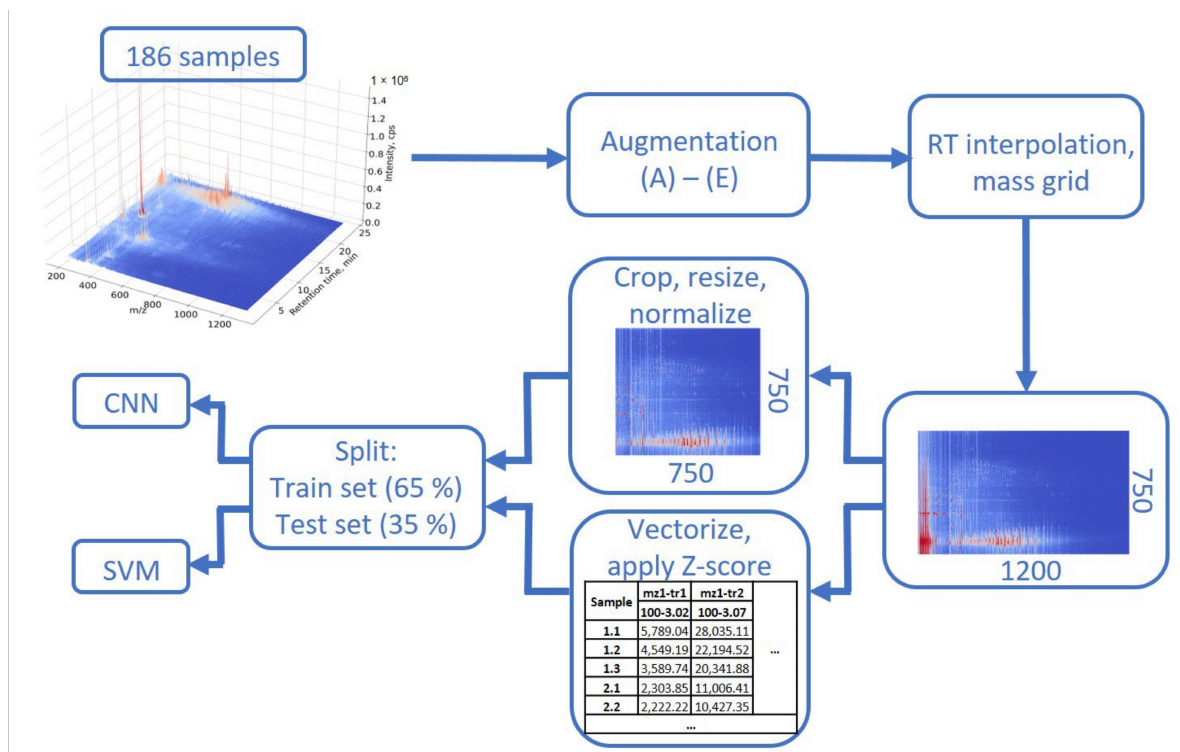
Figure 1. LC-MS data preparation pipeline for CNN and SVM application. Table 2. Description of the procedures employed for data